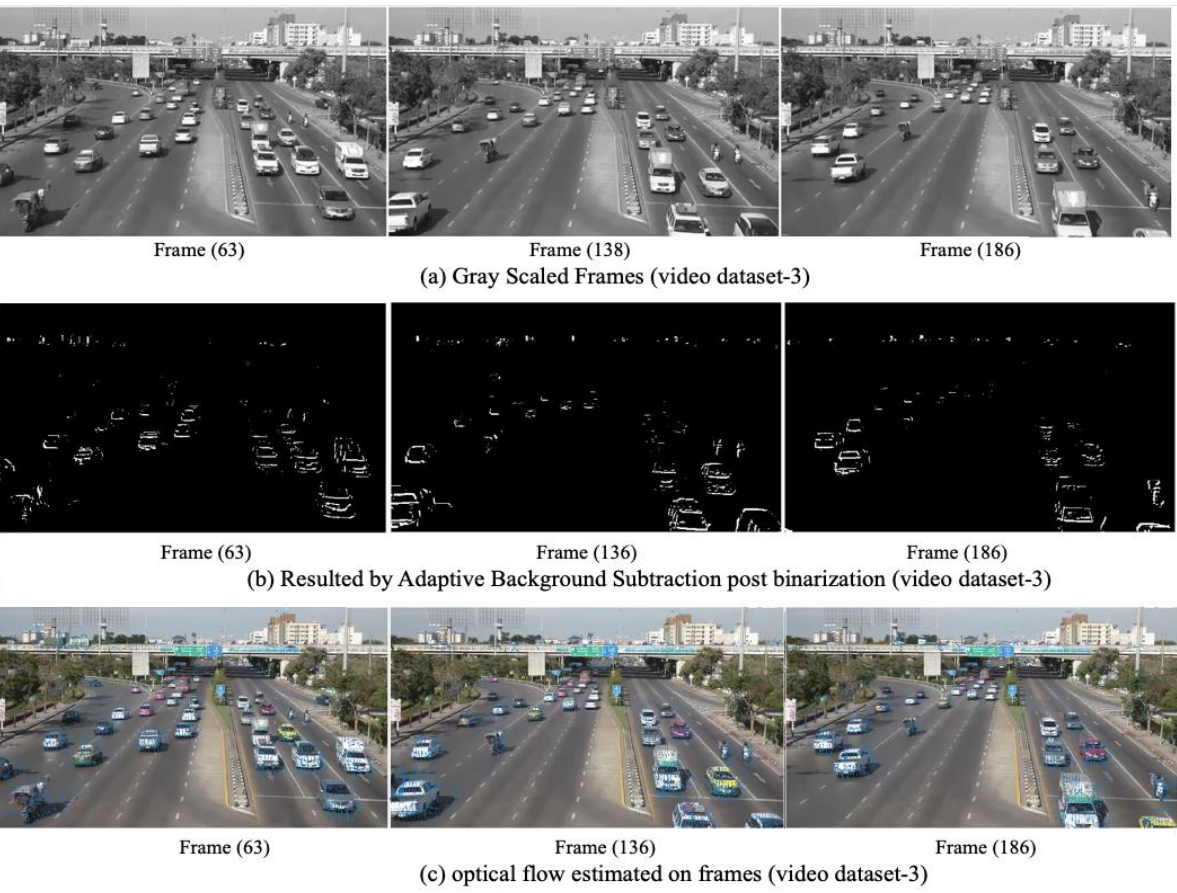
Figure 8. Simulation results from video dataset 3 by the proposed framework (( a ) extracted frames in grayscale, ( b ) foreground by adaptive background subtraction post-binarization and ( c ) optical flow).